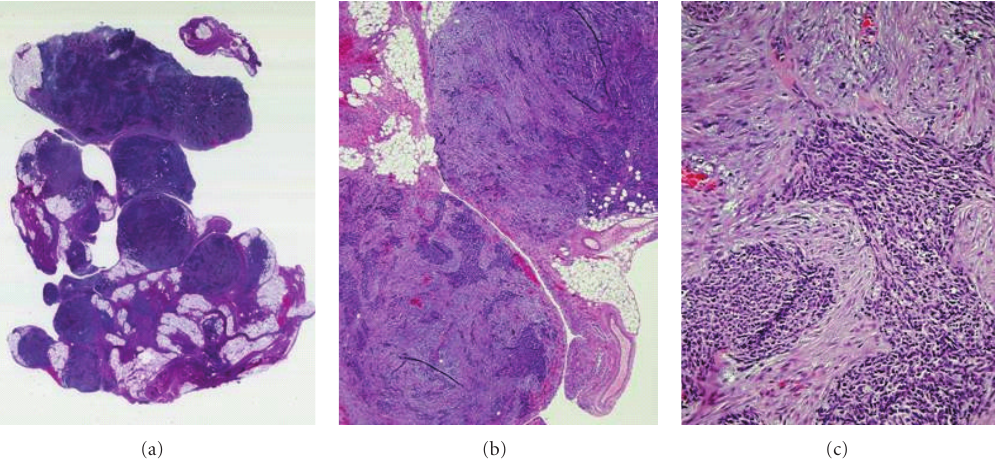
Figure 1: Peritoneal nodule of DSRCT at diagnosis . Nodules are composed of fibrocollagenous tissue and irregular islands of malignant undi ff erentiated small round cells. Immunoperoxidase stains (not shown) in this case were strongly positive for EMA, vimentin, and desmin, partially positive for CD99 and negative for synaptophysin, chromogranin, myogenin, SMA, Bcl-2, CD3, and CD20. Cytogenetic analysis demonstrated t(11;22)(p15;q12). Magnification: (a) × 10, (b) × 40, (c) high